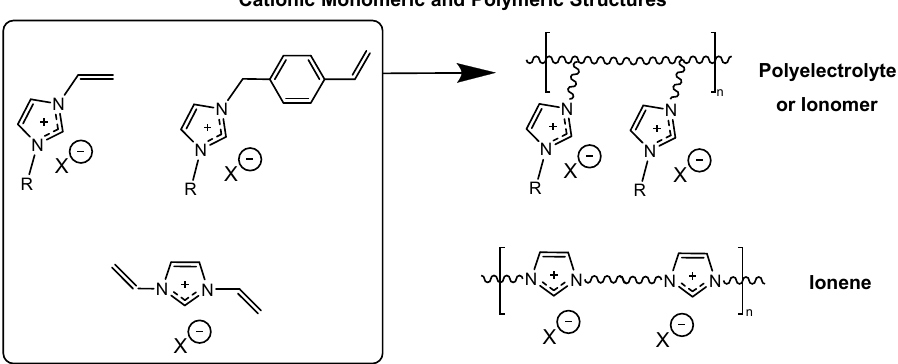
Figure 1. General representation of imidazolium-based building blocks for cationic polymers including polyelectrolytes and ionomers, compared with structurally similar ionenes.